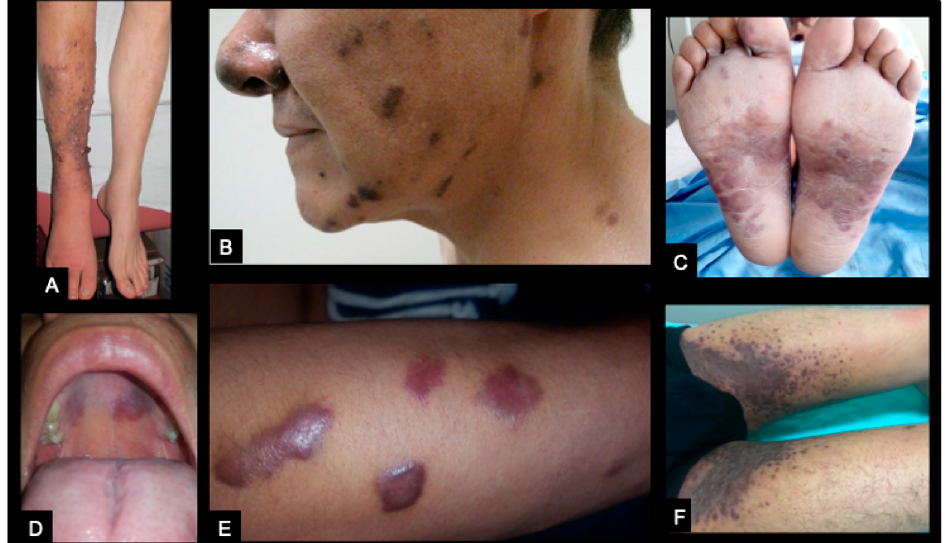
Figure 1. Skin lesions from HIV patients with disseminated Kaposi Sarcoma diagnosis (KS/HIV patients). Representative clinical images showing different clinical presentations of lesions from KS/HIV patients. ( A ) Exophytic and verrucous lesions limited to the right leg with lymphedema. ( B ) Dark plaques in face and nose. ( C ) Erythematous plaques insoles. ( D ) Violaceous macules in the palate. ( E ) Violaceous and elevated plaques in the forearm. ( F ) Bilateral groin infiltration with confluent violaceous plaques. Table 1. Characteristics of KS/HIV